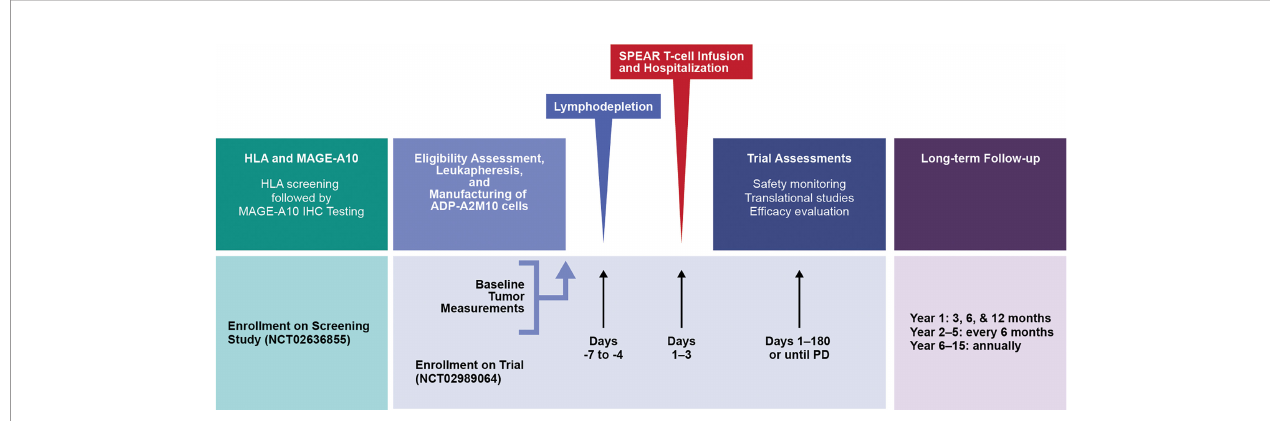
FIGURE 1 | Study design. HLA, human leukocyte antigen; IHC, immunohistochemical; MAGE, melanoma-associated antigen; PD, progressive disease; SPEAR, speci fi c peptide enhanced af fi nity